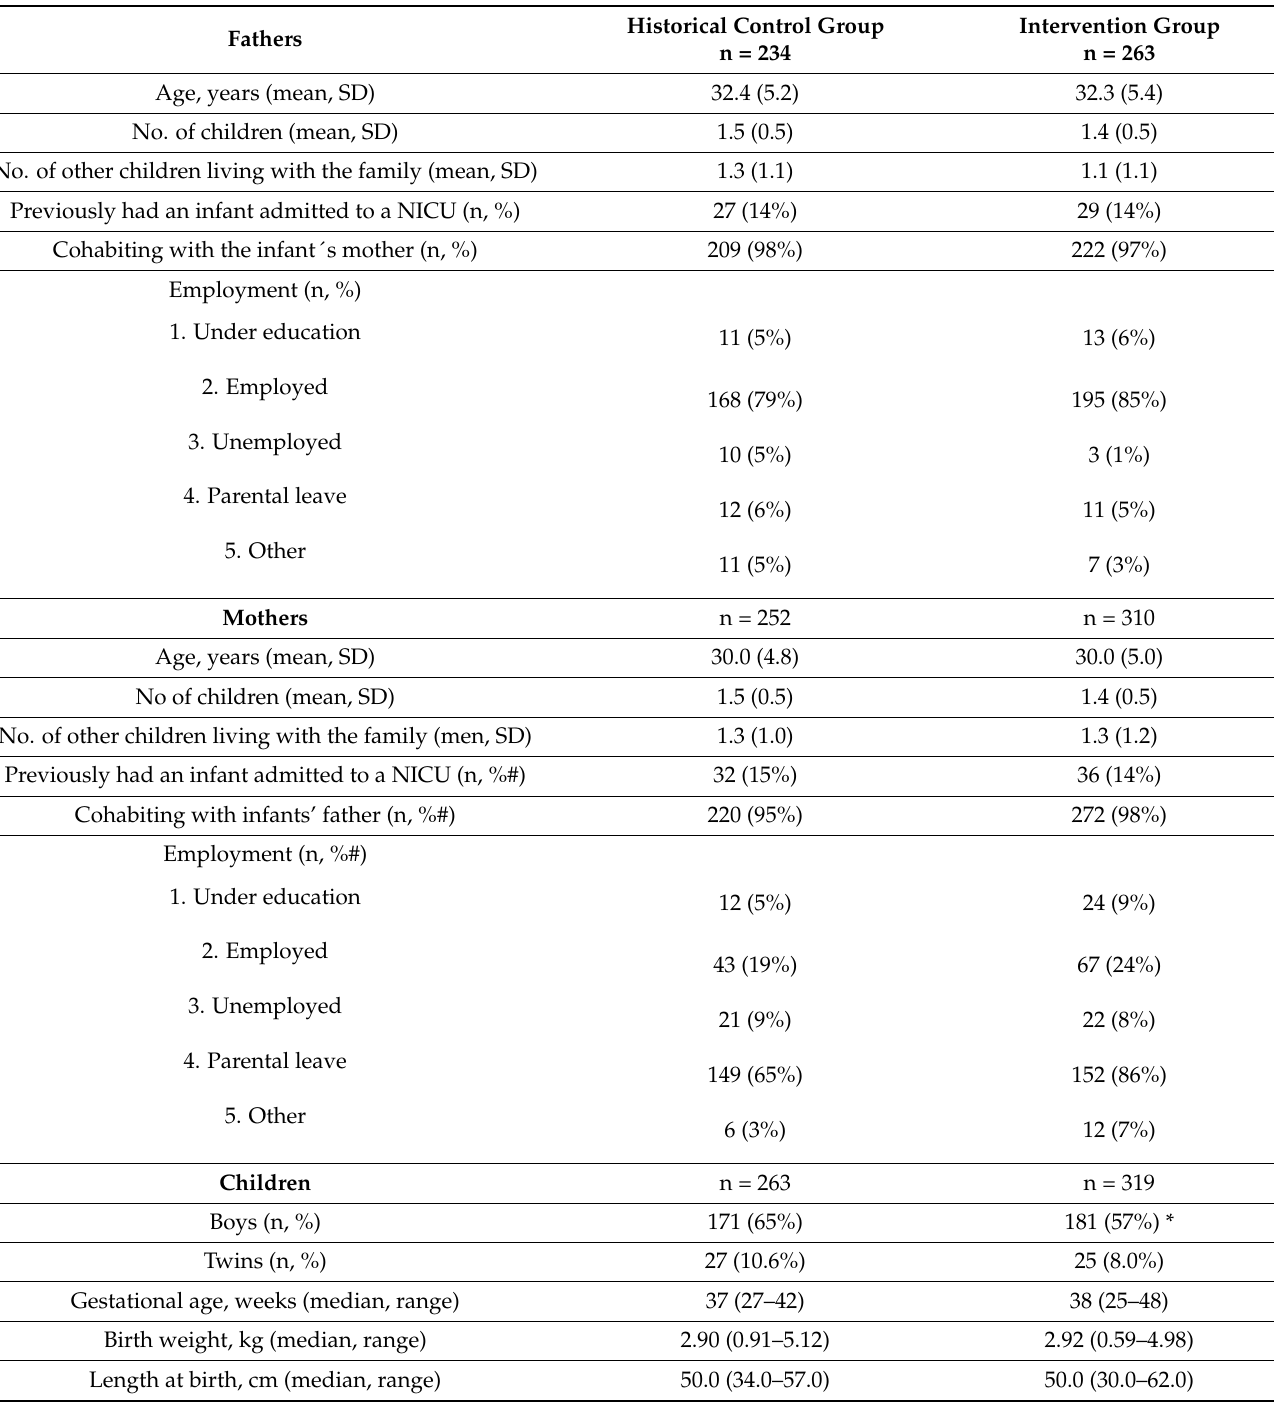
Table 1. Demographic and clinical data on the